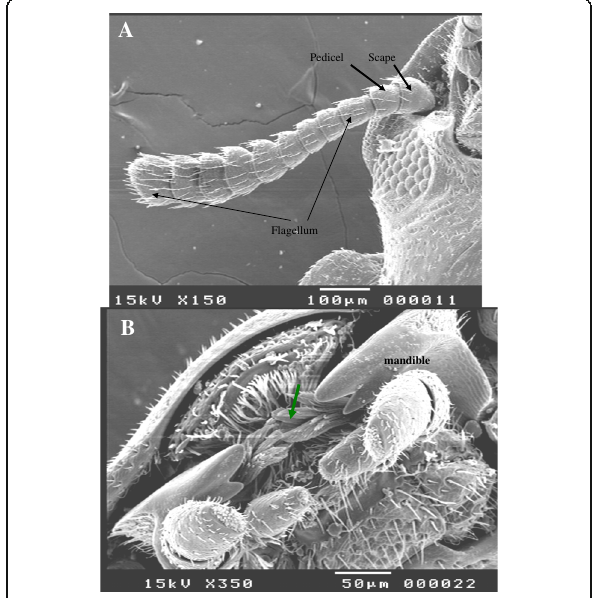
Fig. 3 a SEM micrograph of the antenna of the adult of T. confusum . b Higher magnification of the head of the adult of T. confusum showing the mouth parts, the mandible with highly sclerotized appendage. The galea with brush of spines distally ( green arrow )